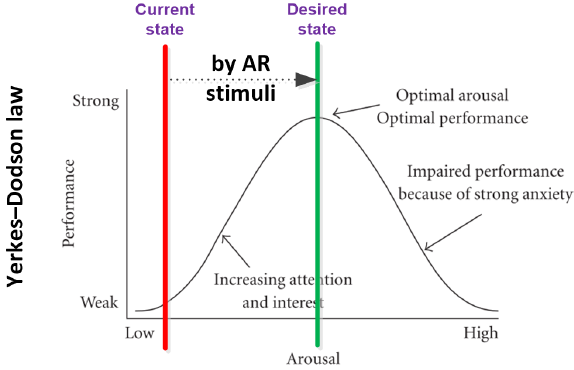
Figure 4. Yerkes-Dodson-Law